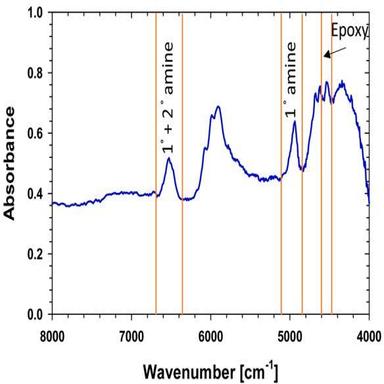
Absorbance spectrum of the Epon 828/MXD system containing 2% nonylphenol obtained during DIW printing using an inline spectrometer. Peaks of interests are marked with vertical lines.